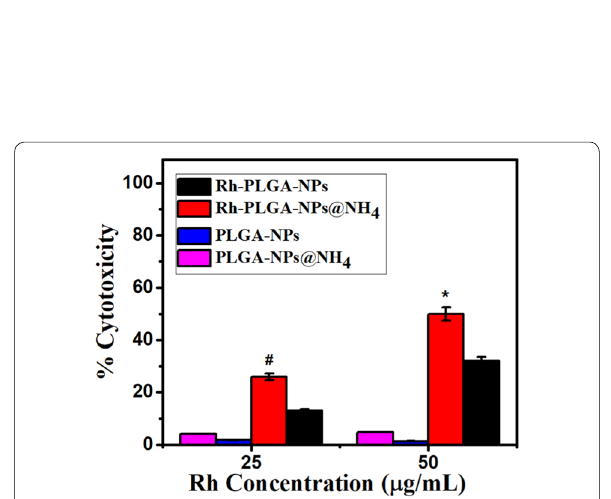
Fig. 4 % Cell viability of THP-1 cell exposed to concentrations 25 µg/ mL and 50 µg/mL of control, Rh-PLGA-NPs and Rh-PLGA-NPs@NH 4 (n 06). (*p < 0.01; Rh-PLGA-NPs@NH 4 vs. Rh-PLGA-NPs, # p < 0.05; = Rh-PLGA-NPs@NH 4 vs.